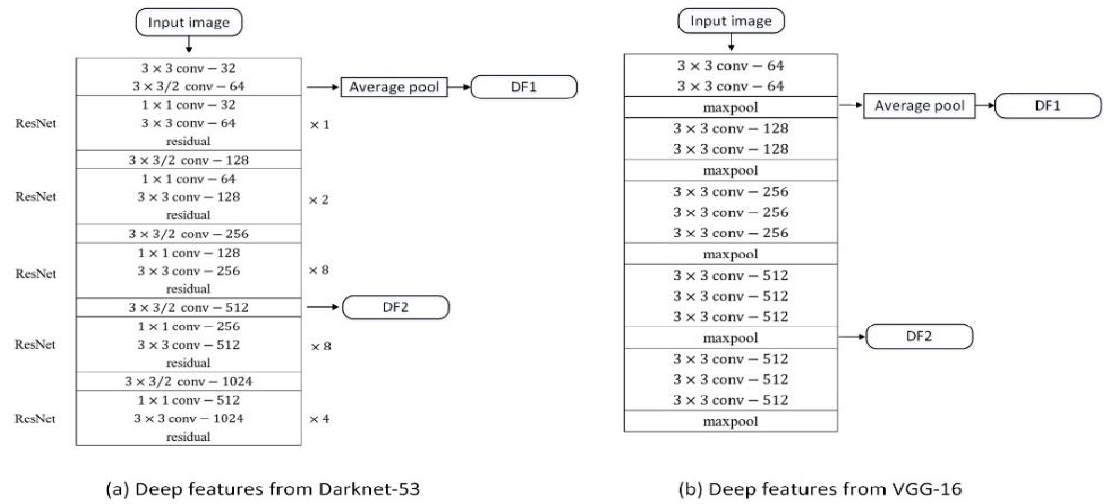
Figure 2. Deep feature extracted from CNN. ( a ) corresponds to YOLO v3. ( b ) corresponds to Faster R-CNN.